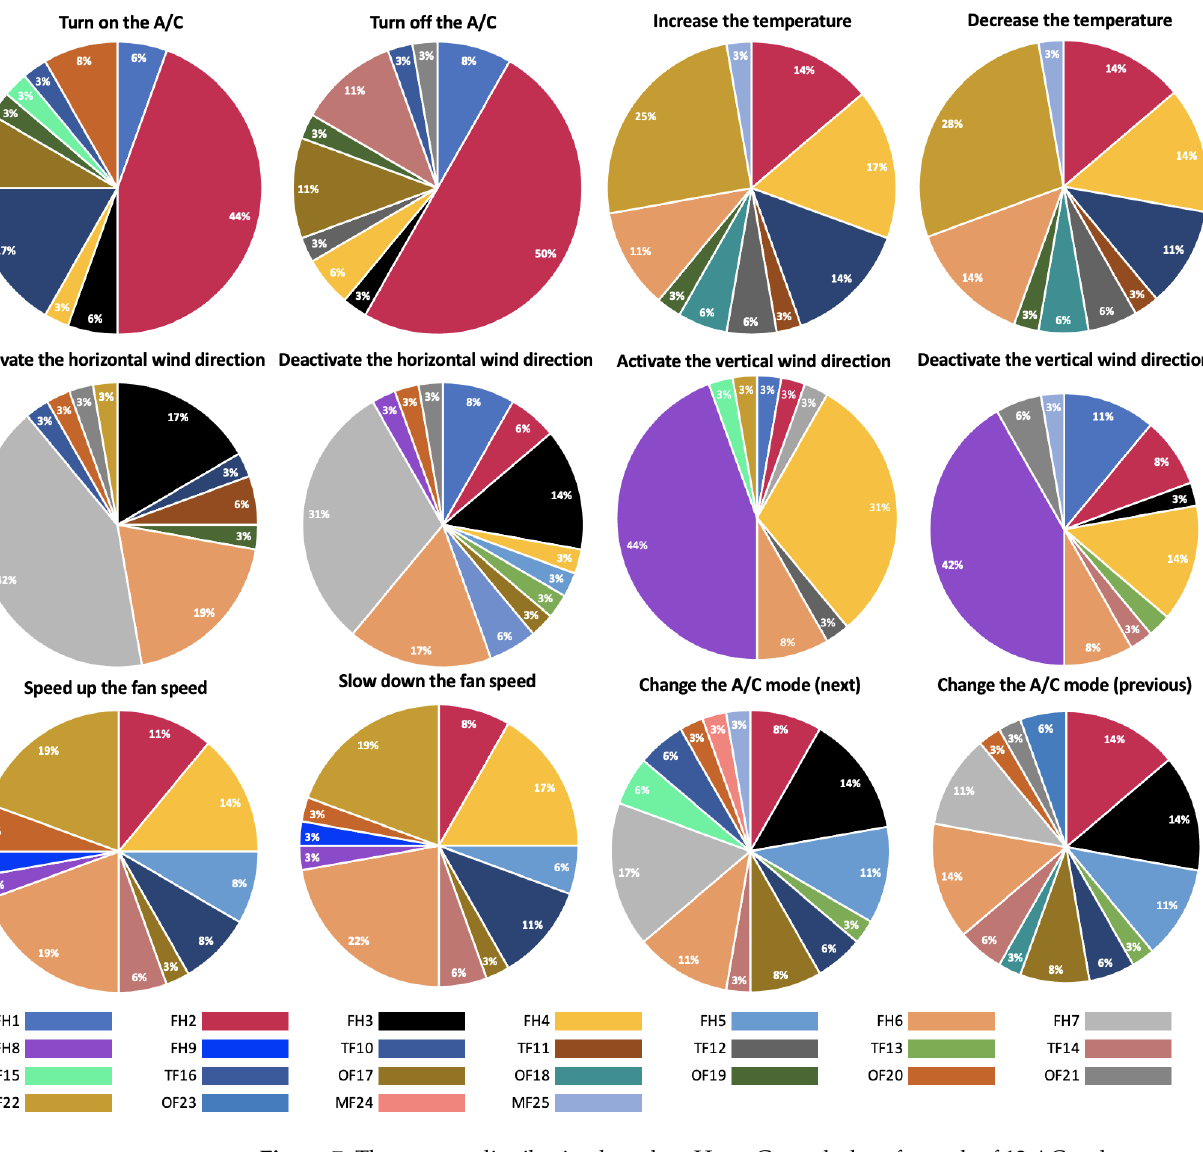
Figure 7. The gesture distribution based on HomeG vocabulary for each of 12 AC tasks.